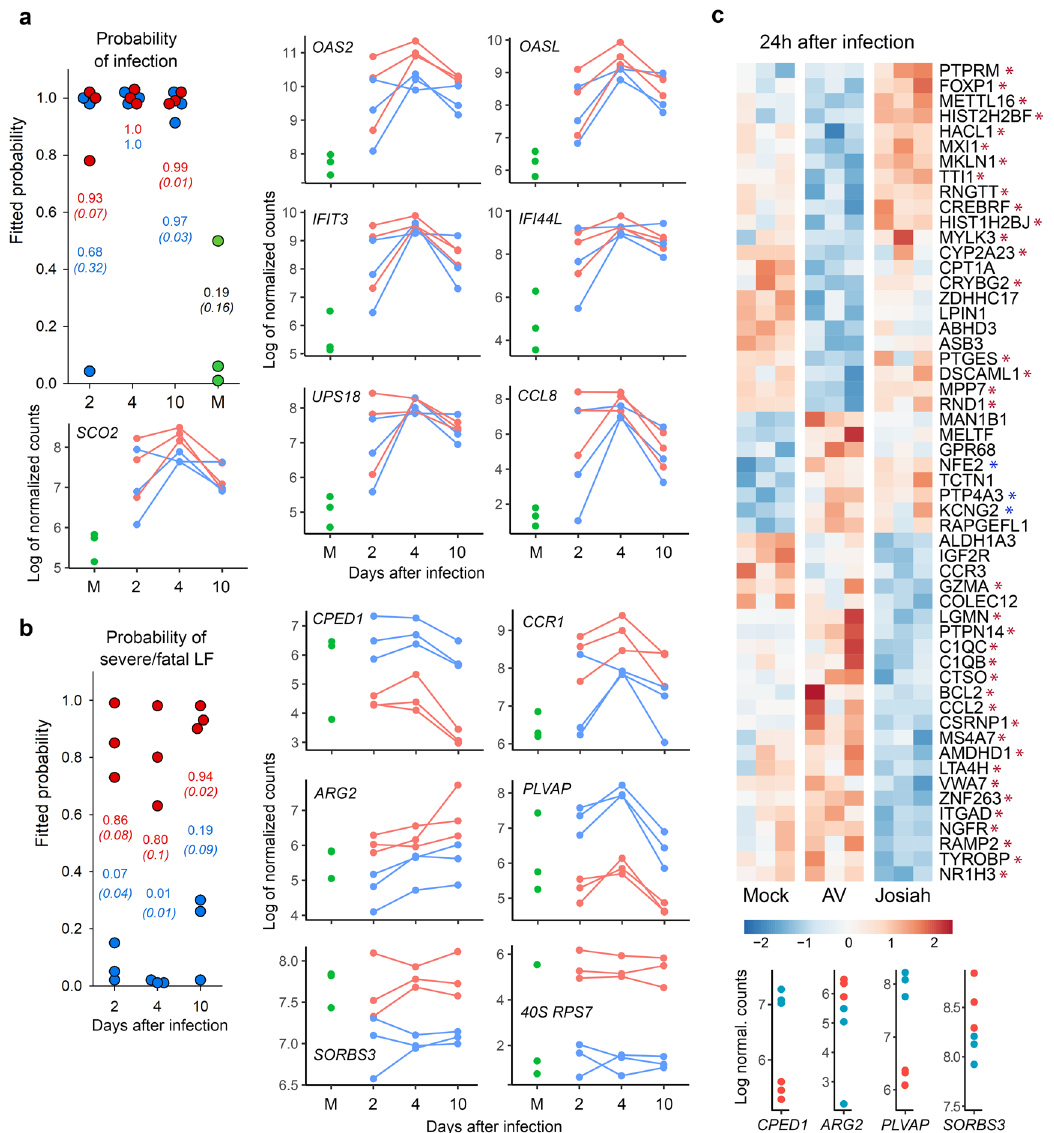
Fig. 10 Identi fi cation of genes that can be used as early markers of infection and severity. a Individual probabilities of infection status estimated by a random forest: each dot represents an estimation of the probability for an animal to be infected or not, at 2, 4, and 10 DPI and at 28 DPI for mock animals: the higher the probability, the greater the risk of an animal being infected. Josiah-infected animals are represented by red dots, AV-infected animals by blue dots, and mock-infected animals by green dots. The mean probability ± SEM is represented in red for Josiah, blue for AV, and black for mock animals. Probabilities were computed by applying the random forest method to the gene expression of OAS2, OASL, IFIT3, IFI44L-201, SCO2, USP18 , and CCL8 . The kinetics of Log2 normalized counts are also shown for each gene. b Individual probabilities to have a severe/fatal LASV infection were estimated and are represented as in a , except that mock animals were not included in this analysis. Probabilities were computed by applying the random forest method to the gene expression of CPED1, CCR1, ARG2, PLVAP, SORBS3 , and 40 S RPS7 . c Heatmaps of DE genes in PBMCs at 1 DPI. The genes that were statistically associated with infection status are indicated by a blue asterisk, whereas those associated with disease severity/lethal outcome are indicated by a red asterisk. Gene expression was standardized using VST transformation, hence centered and scaled to make the gene expression comparable. Each column displays gene expression of a given animal. The expression of CPED1, ARG2, PLVAP , and SORBS3 1 DPI in PBMCs of Josiah- and AV-infected NHPs is represented at the bottom by red and blue dots, respectively. The DE of the other genes selected in a and b was not signi fi cant at 1 DPI and are therefore not represented. Transcriptomic changes measured 1 DPI could not be compared with other samples as the sequencing of these mRNA was not performed together with the